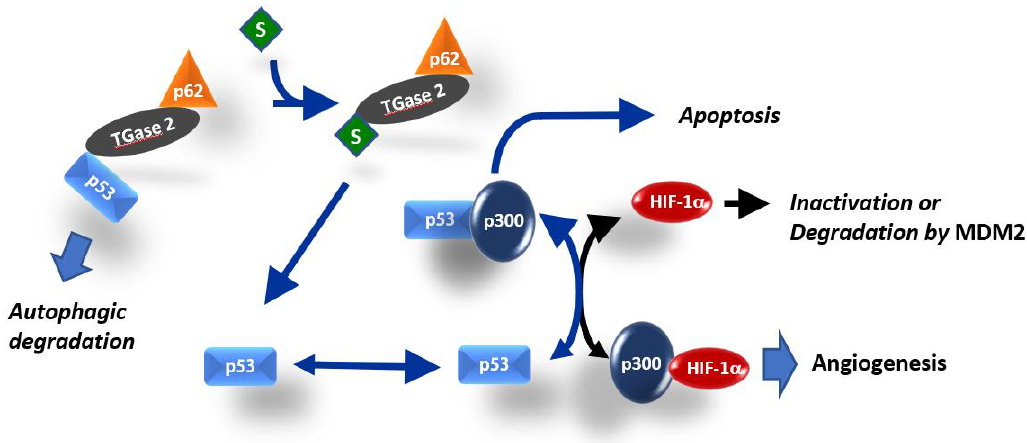
Figure 6. Simplified model for the role of TGase 2 in HIF-1 α activation. HIF-1 α and p53 both require interaction with the transcriptional co-activator p300 for stable transcriptional activity. Interference of each protein with the transcriptional activity of the other is related to the availability of p300 [18,19]. TGase 2-mediated p53 depletion induces angiogenesis by promoting the HIF-1 – p300 interaction in RCC. The TGase 2 inhibition-mediated increase in apoptosis was attributed to increased p53 – p300 binding.